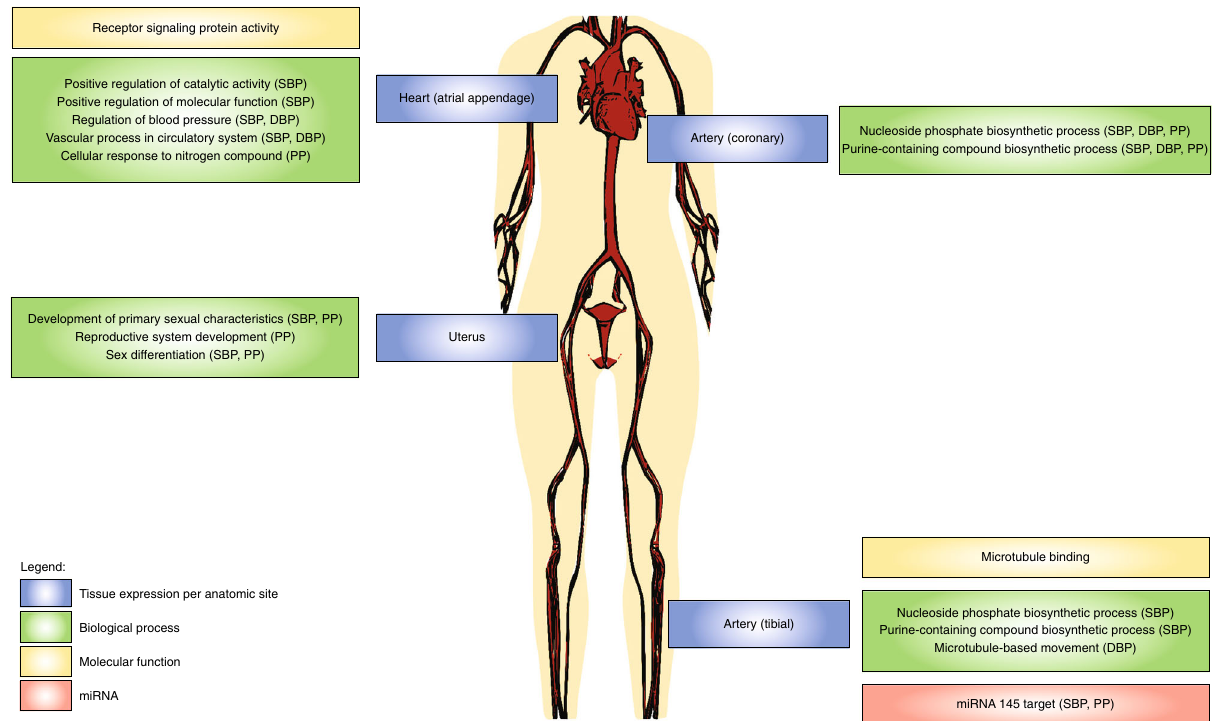
Fig. 4 Illustration of results from post hoc tissue expression by gene set interaction analysis. Only interactions that were initially signi fi cant and retained after follow-up checks are shown. Tissue expression per anatomic site (blue), biological process (green), molecular function (yellow) and miRNA